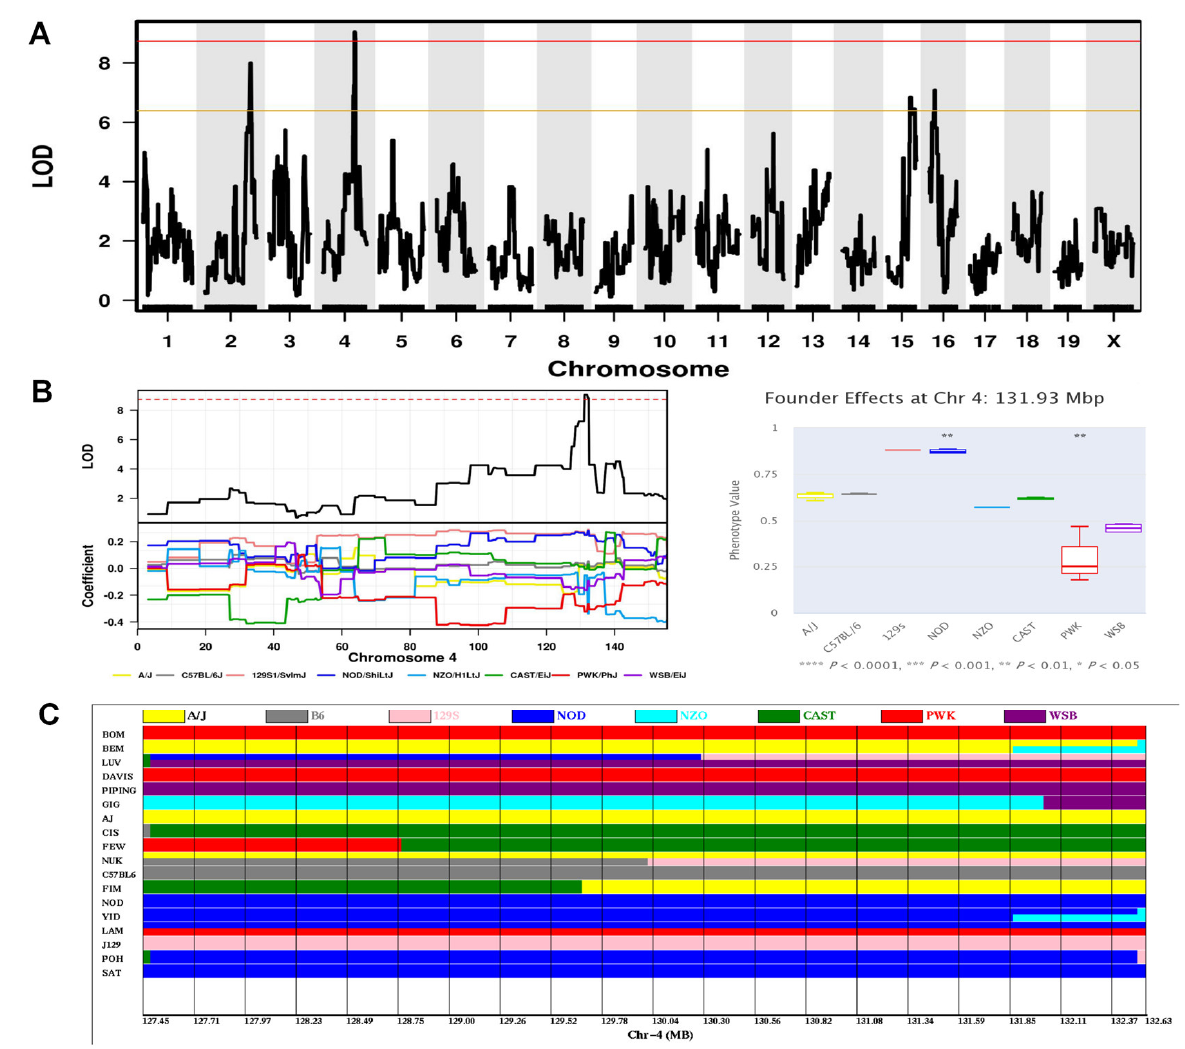
Figure 8. Mapping a significant QTL on Chr4 influencing the percentage of time spent freezing during the first post-shock interval on Day 4 for cued fear conditioning. ( A ) Genome-wide LOD scores. The x -axis shows the chromosomal position and the y -axis shows the LOD scores. The solid red and orange horizontal lines indicate thresholds of 95% and 63% genome-wide significance, respectively. ( B ) LOD scores (upper left panel) on Chr4, and founder coefficient plot (bottom left panel) for Chr4. The dashed red horizontal line indicates thresholds of 95% significance. The association of founder haplotypes at 131.93 Mbp with this trait analyzed is shown in the right plot, indicating that the NOD haplotype ( p < 0.01) and 129S1 haplotype were associated with highest percentage of time spent freezing, while the PWK haplotype ( p < 0.01) was associated with lowest percentage of time spent freezing. ( C ) Founder haplotypes in all CC strains at position 127.45–132.63 Mbp on Chr4. Strains are listed in the order from lower percentage (top) to higher percentage